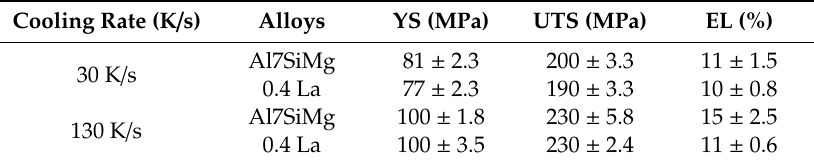
Table 3. Tensile properties of Al7SiMg and Al7SiMg + 0.4La alloys at di ff erent cooling rates. (YS = yield strength, UTS = ultimate tensile strength, EL = elongation).